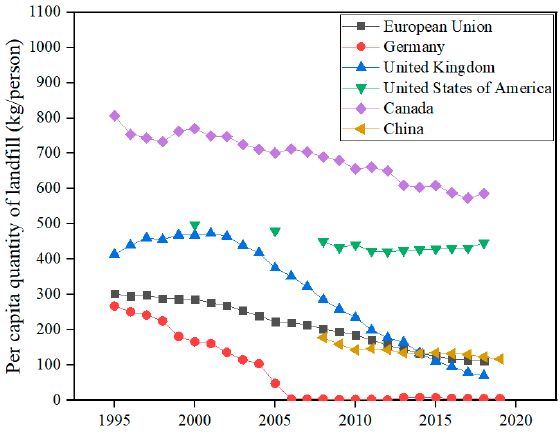
Figure 3. Per capita quantity of landfill.